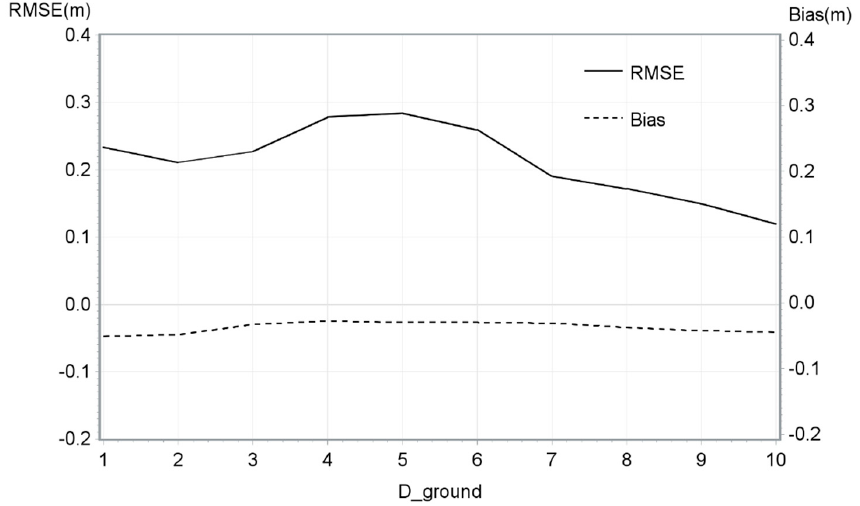
Figure 6. RMSE and mean bias of the DTM model by D_ground.